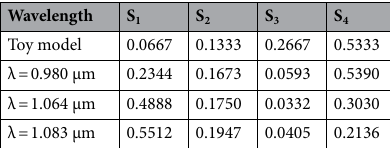
Table 4. The layer sensitivity at three certain wavelengths, 0.98um, 1.064um, and 1.083um and in a toy model.